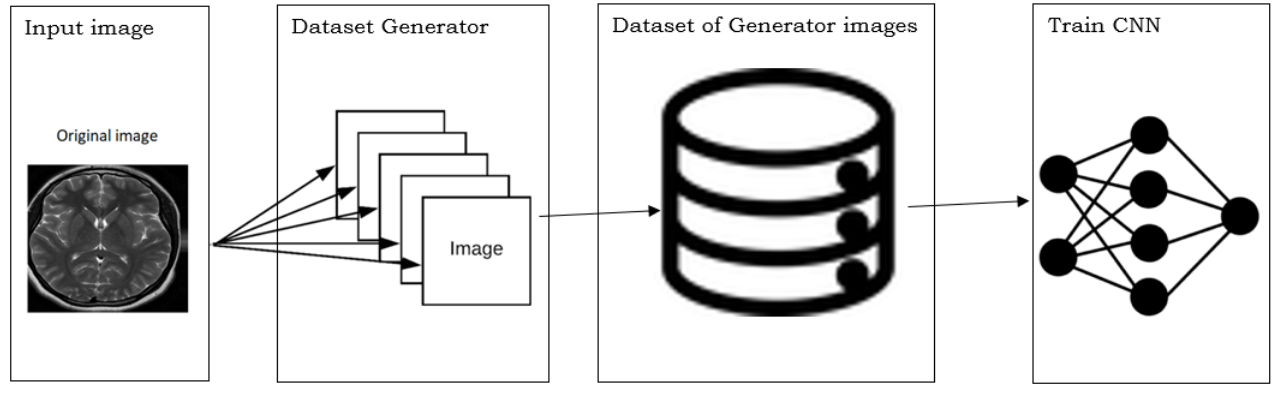
Figure 5. Dataset generation and expanding an existing